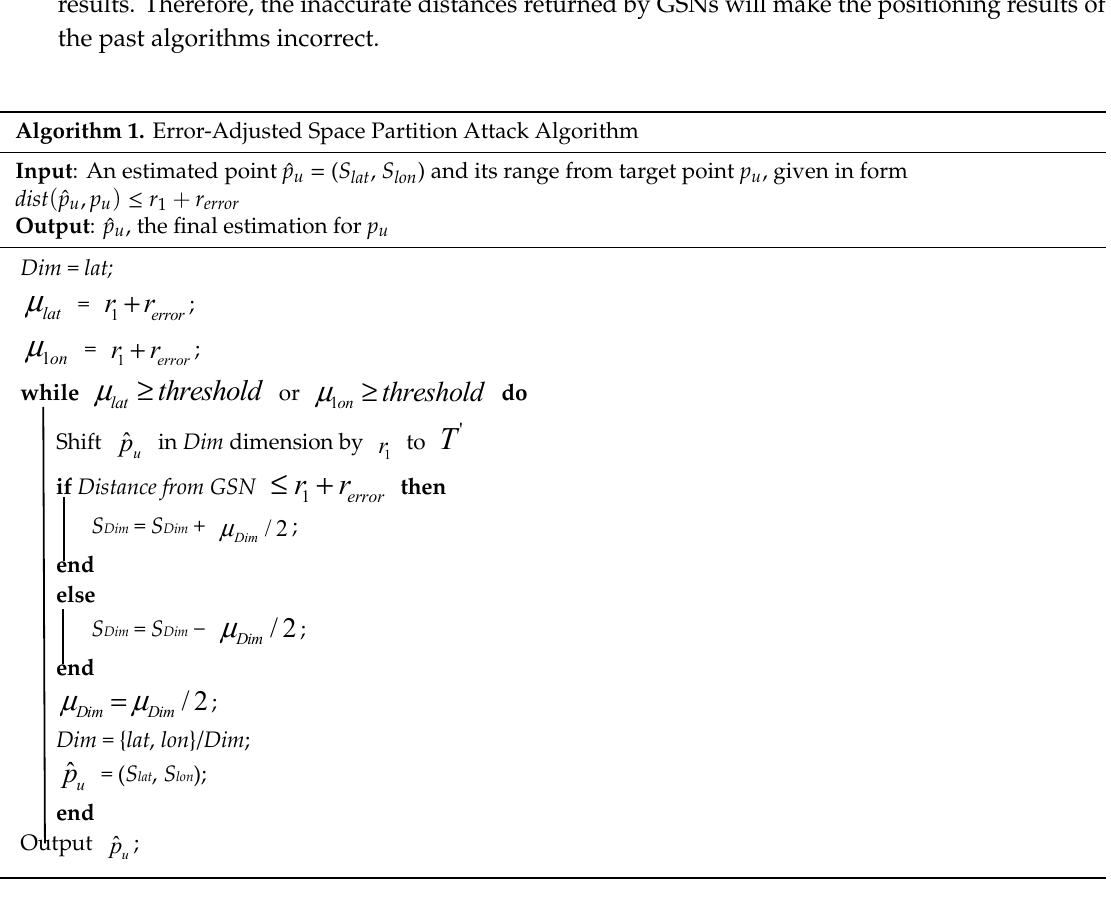
Table 2. The variables in